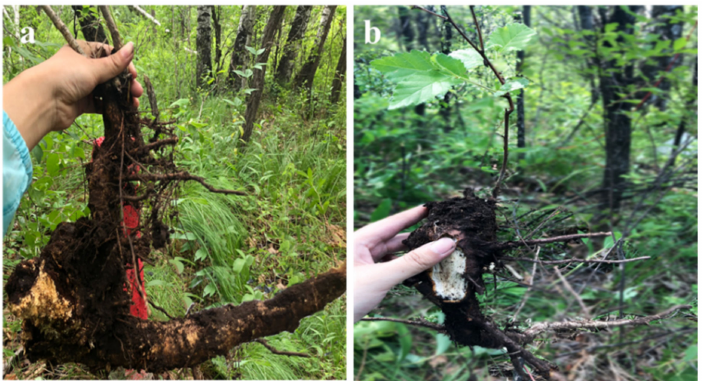
Figure 1. Sprout regeneration sapling and seedling. ( a ), The lateral roots of sapling are connected to the parent tree. ( b ), The roots of the seedling are much older than the seedling